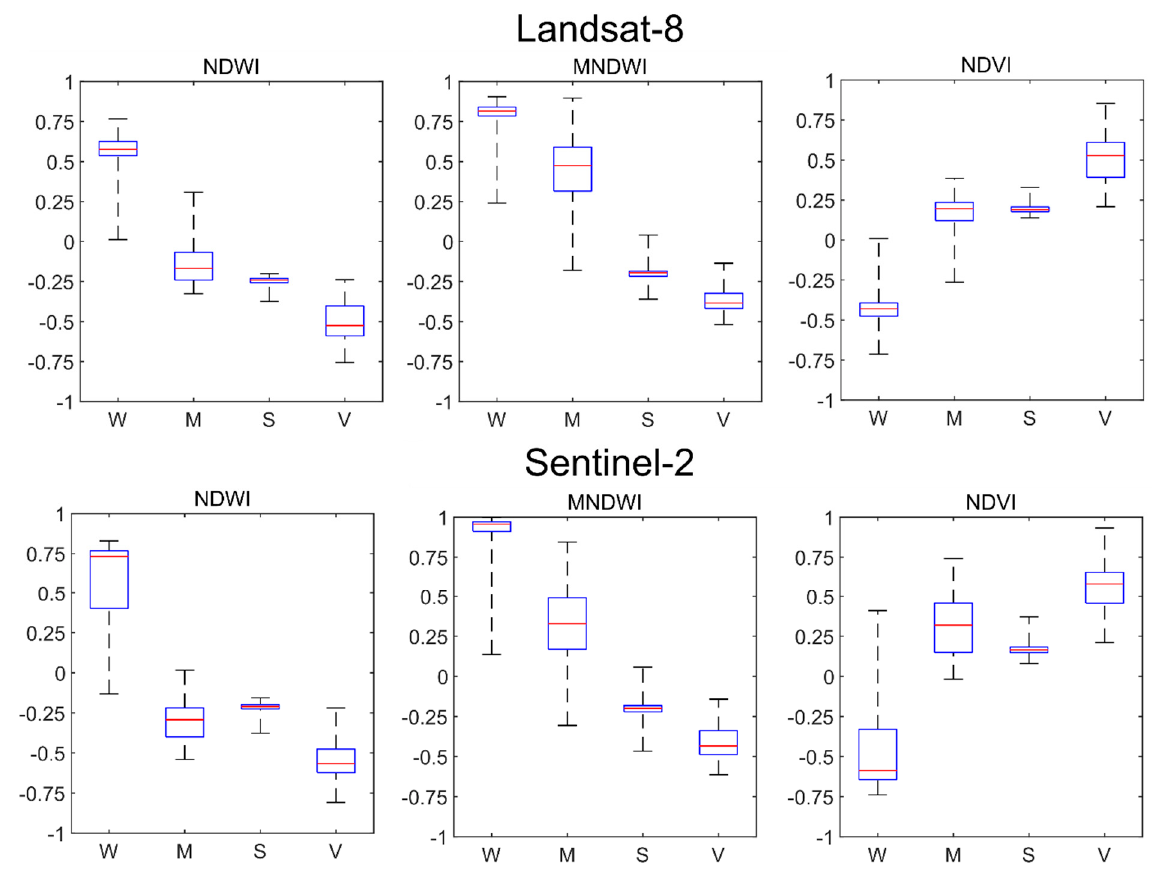
Figure 4. Distribution of indices values for the four land cover classes ( W , M , S , V